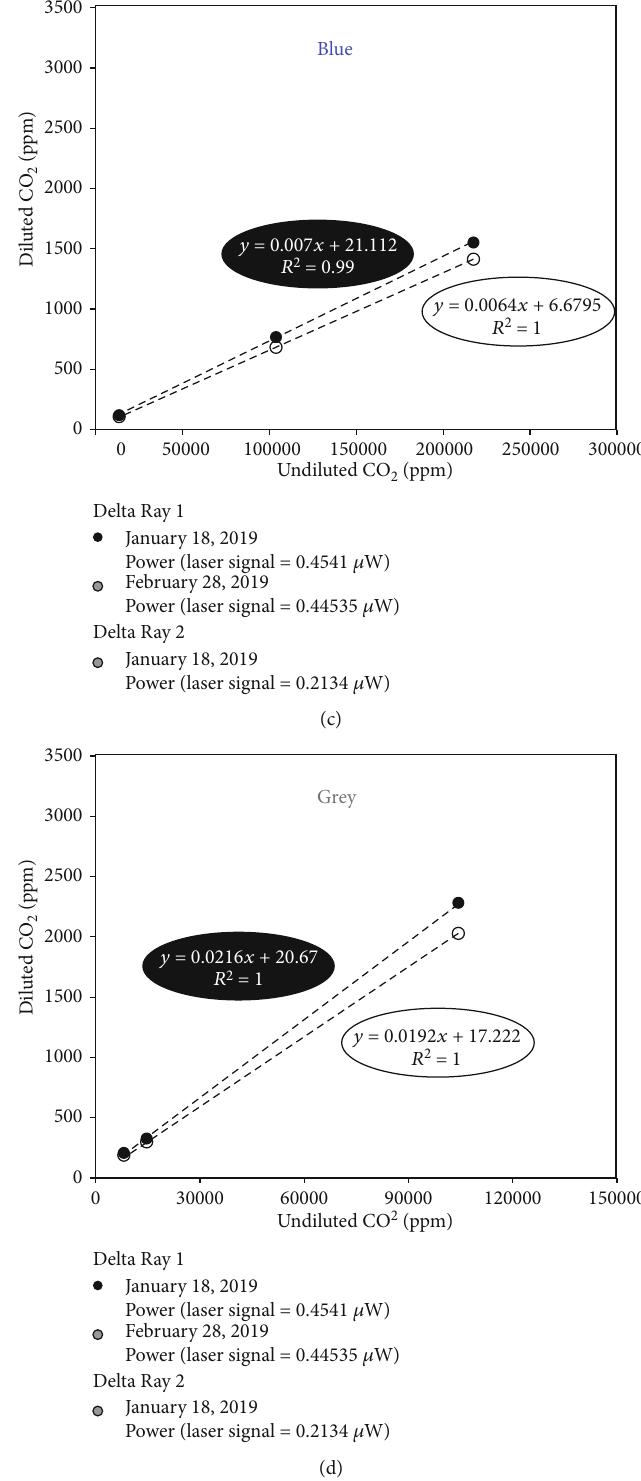
Figure 7: Comparison between real CO contents and measured diluted ones from Delta Ray IRIS with either the (a) yellow, (b) pink, (c) blue, 2 or (d) gray dilution wires. The two Delta Ray IRIS instruments available at the INGV Palermo (DR1 and DR2) were used for this test leading to distinct coe ffi cients for the equation of linear regression. CO contents of reference gases varying from 1 to 95% (see Appendix 2